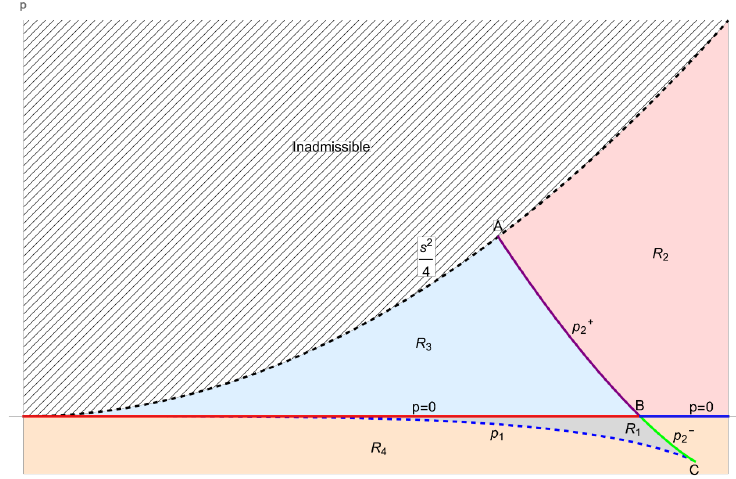
Figure 1 . A plot of the various domains of validity for solutions in ( s, p ) space. The three coloured regions denoted R 1 , 2 , 3 allow for a global completion to a compact space, while region 4 allows for non-compact domain-wall solutions. The regions are separated by various lines, the non-trivial lines p = p 1 ( s ) and p = p 2 ( s ) are given explicitly in (2.12) and (2.14). We have added a ± superscript on p 2 to denote whether it is above or below the axis, the form of p 2 is independent of this. There are three distinguished points arising from the intersection of the boundary lines: A = (cid:0) 2 (cid:1) (cid:0) 8 √ 2 (cid:1) B = , 0 and C = , − 4 √ 27 729 3 3